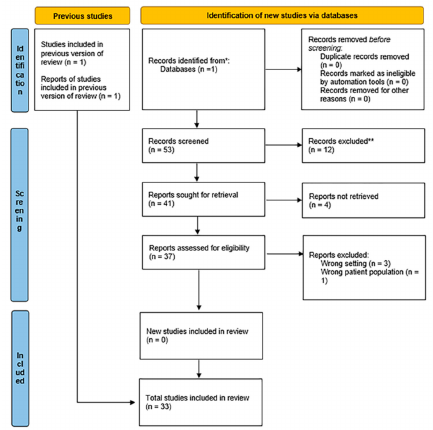
Figure 1. PRISMA flowchart that illustrates the procedure followed for the preparation of this review